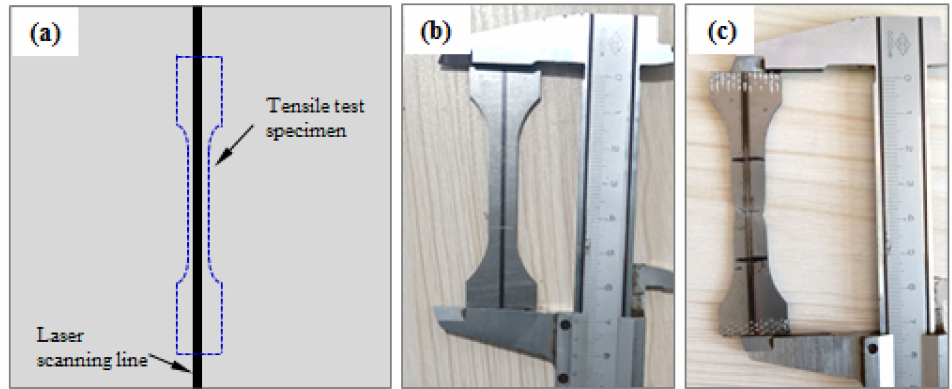
Figure 2. Cutting position and the photo of the tensile test specimen: ( a ) cutting position; ( b ) the photo of the specimen before the tensile test; ( c ) the photo of the specimen after the tensile